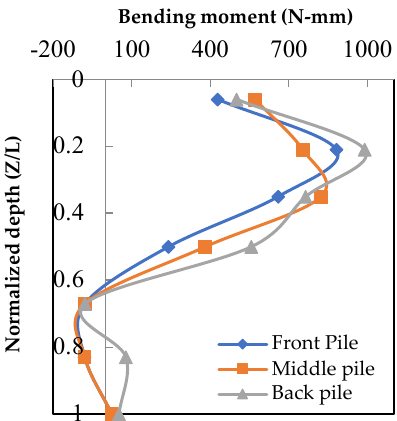
Figure 11. Bending moment profile of the piles for slenderness L = 60 D and spacing S = 3 D. Moreover, the effect of pile slenderness ( L/D ) on the bending moment values was investigated. The bending moment profile over the length of the pile for various lengths of 15 D , 30 D , 45 D , and 60 D for the pile-to-pile spacing of 3 D is plotted in Figure 12a. The maximum value attained for the L/D = 15 is 495 N-mm at the level of 0.25 L from the top of the pile. It is clear from the bending moment profile plot for the slenderness ratio of L/D = 15 that the piles behave as a short rigid component. The bending moment of the piles also increased as the slenderness ratio increased. This response is similar to the dynamic bending moment profile reported by [90,99]. The maximum bending moment values computed for piles with slenderness ratios L/D = 30, 45, and 60 were 572 N-mm, 780 N-mm, and 881 N-mm, respectively. Thus, it can be inferred from the bending moment plots that the piles started behaving as flexible components when the slenderness ratio increased.